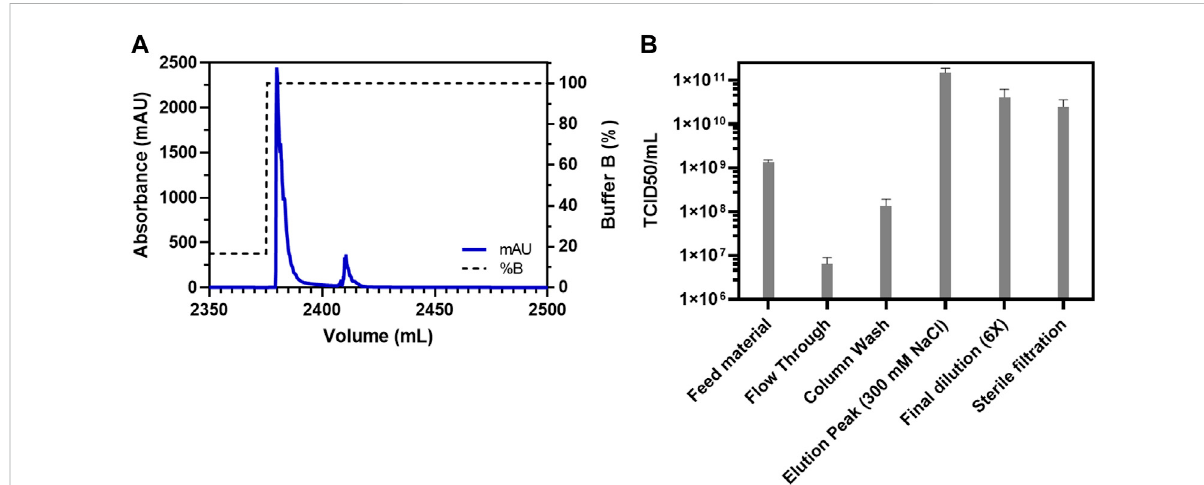
FIGURE 2 Consolidation runforthepuri fi cationofVSV-GPfromcrudefeedonSartobind Smembraneadsorber. (A) Chromatogramforthepuri fi cationof VSV-GP using Sartobind S membrane adsorber column. The fi rst peak contained the virus with a volume of 8 ml and (B) TCID 50 -based infectivity assay for various fractions obtained during puri fi cation of VSV-GP in (A) with fi nal a recovery of about 30% in the elution